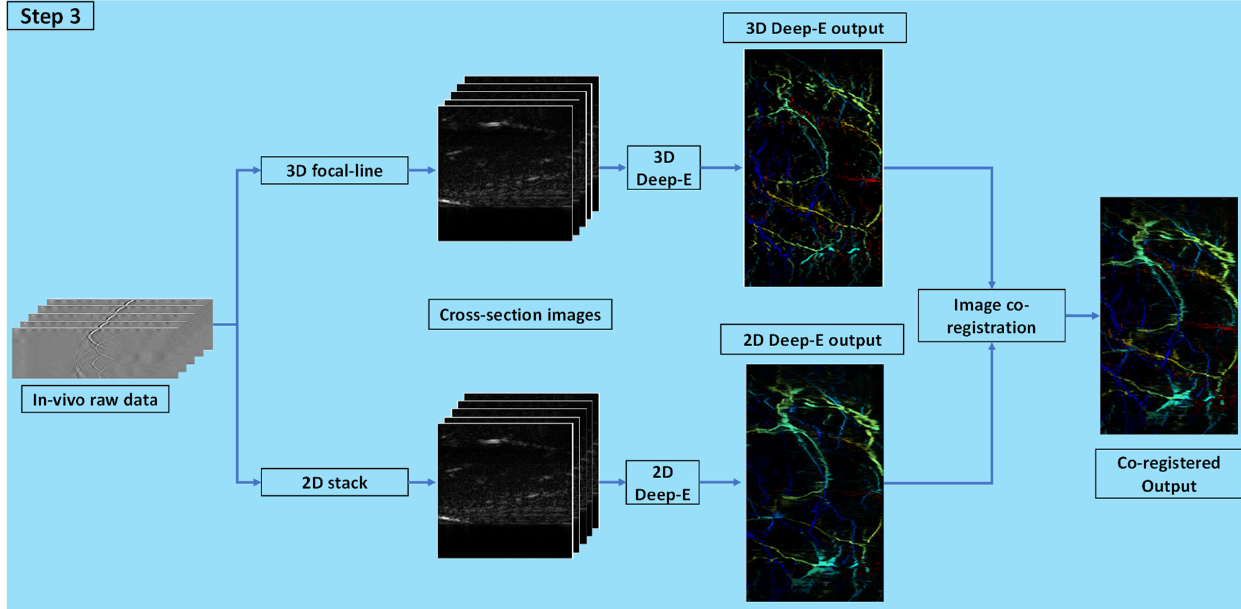
Figure 3. Workflow of training data generation, experimental data reconstruction, and post-training data processing.